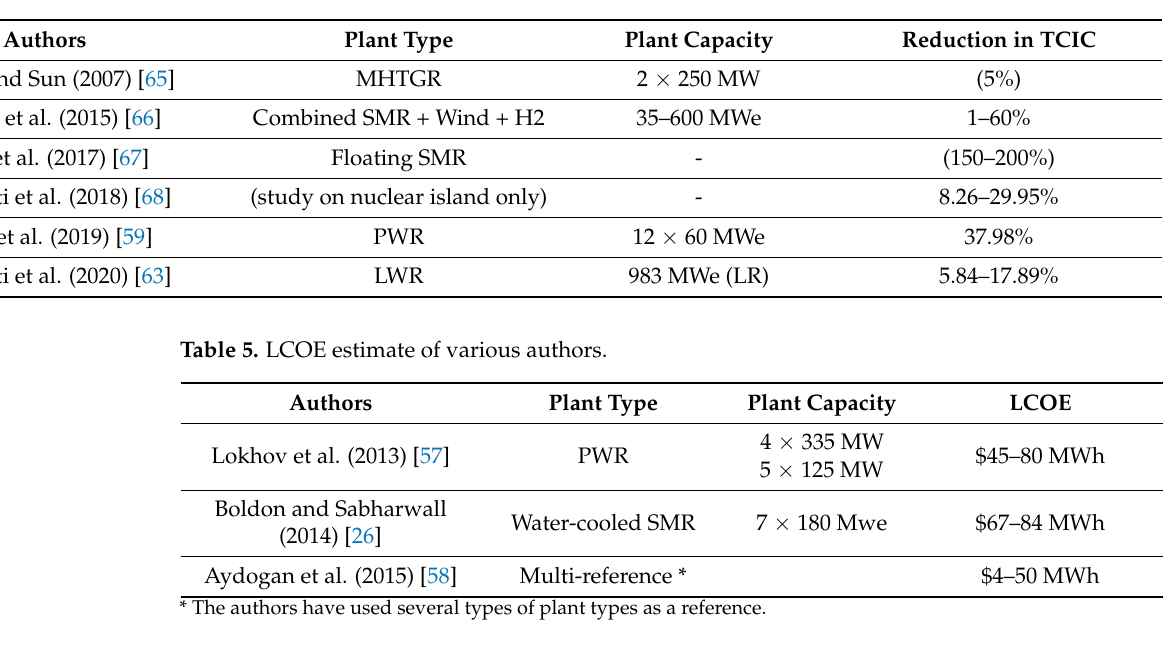
Table 4. Estimated percentage reduction in TCIC by various authors.